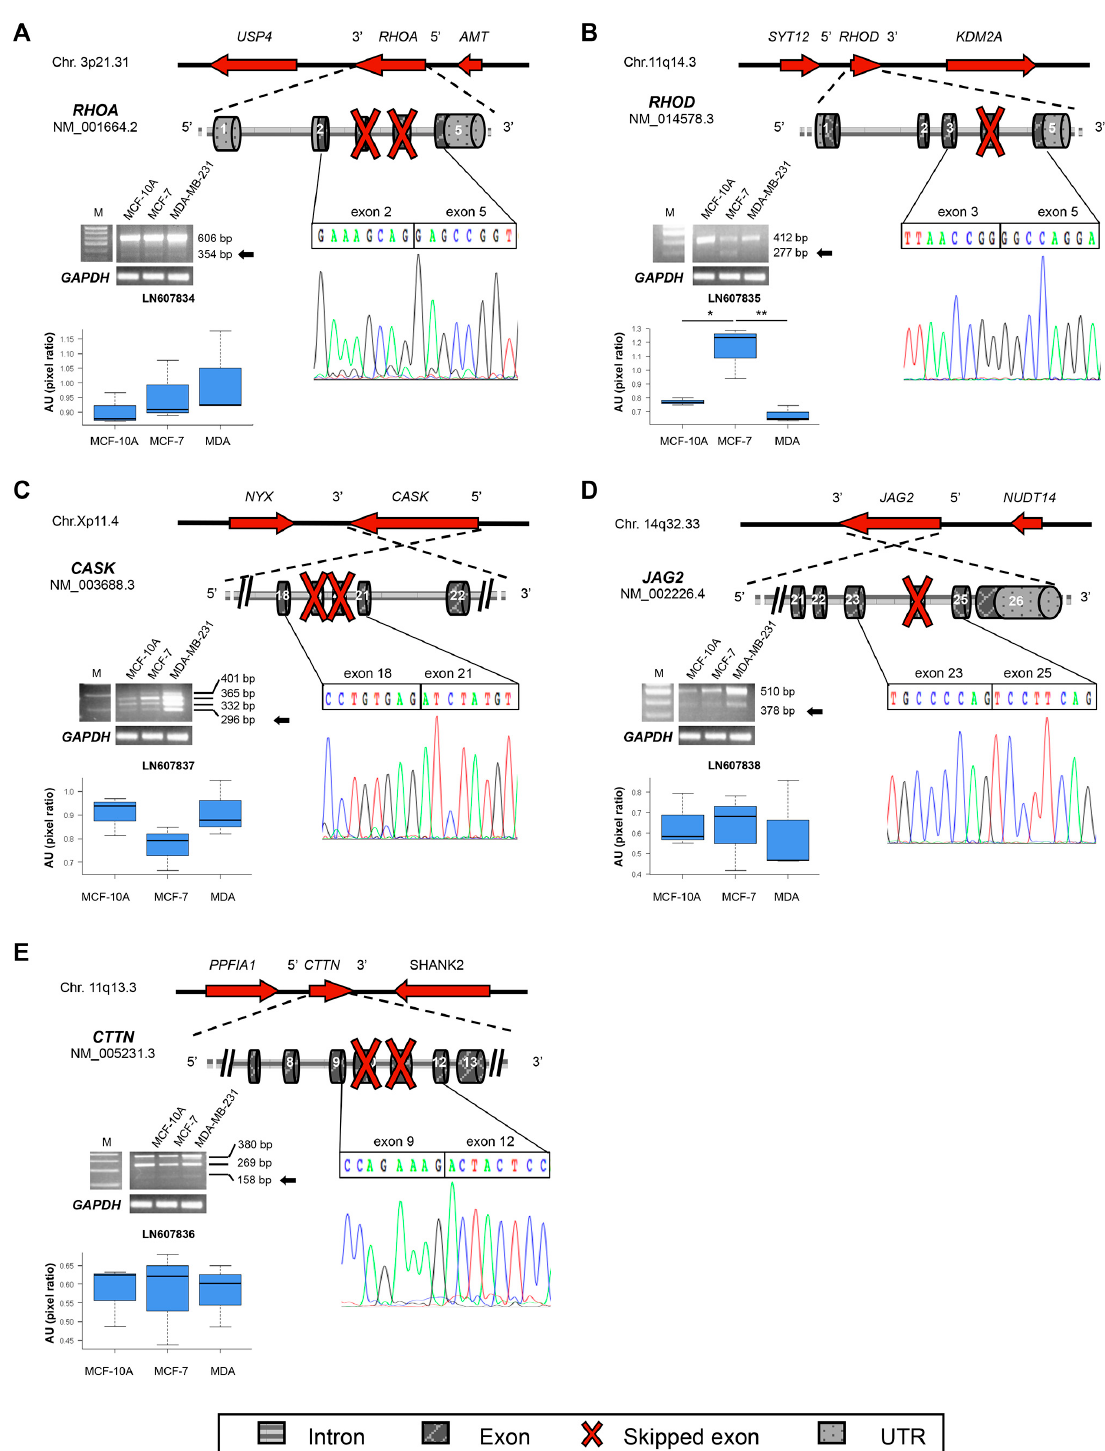
Figure 3. Schematic representation of de novo identified transcripts of motility-related genes and their expression by RT-PCR in breast cell lines (a representative image is shown for each gene). ( A ) RHOA ; ( B ) RHOD ; ( C ) CASK ; ( D ) JAG2 ; ( E ) CTTN new transcripts. Details about the gel bands and their quantification are provided in Figure 2 legend. Asterisks indicate significant p values (* p < 0.05; ** p < 0.01).